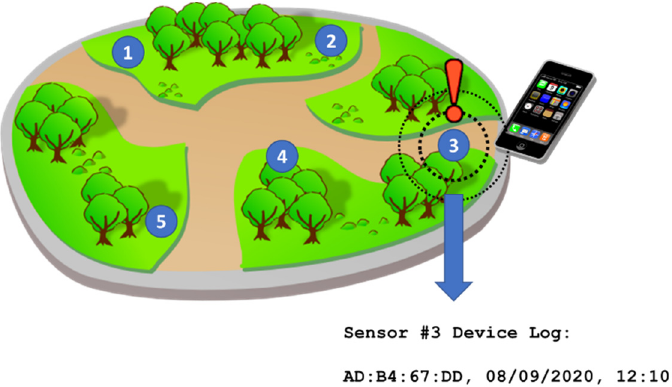
Figure 1. An example of Multiple WiFi Sensors (sensors 1-5) installed across a Forest Trail to track devices and hence track route of travel